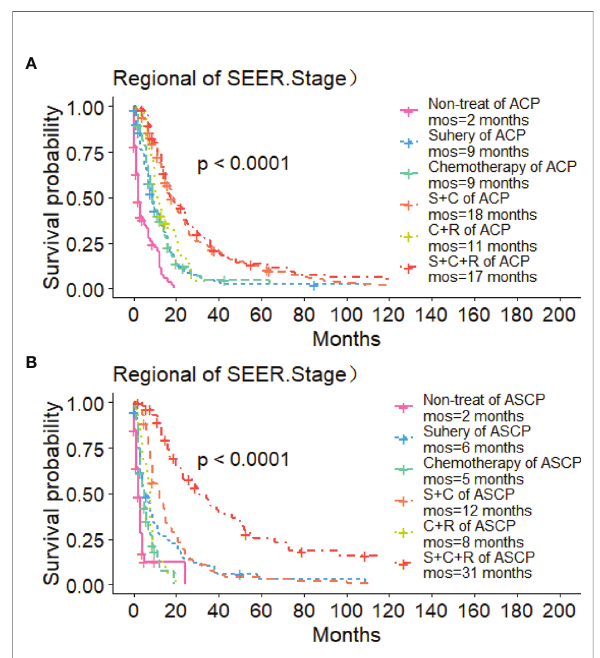
FIGURE 5 | Role of Radiotherapy in ACP and ASCP: (A) Role of Radiotherapy in ACP Regional Stage; (B) Role of Radiotherapy in ASCP Regional Stage (S, surgery; C, chemotherapy; R, radiotherapy).